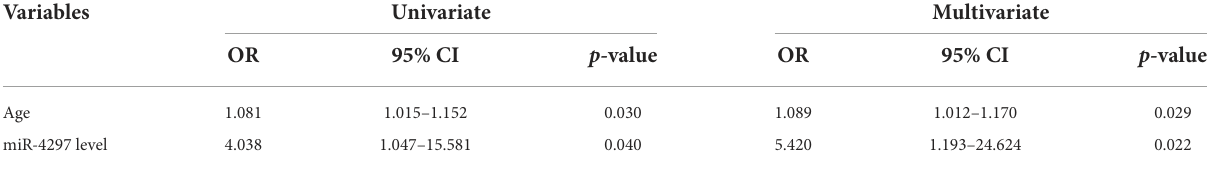
TABLE 3 Univariate and multivariate predictors for HGGs in females.